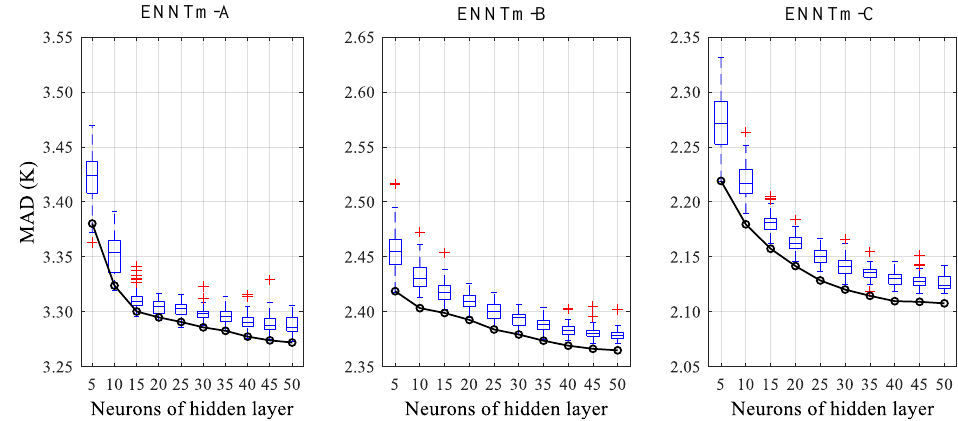
Figure 4. The MAD of different modeling schemes with different BPNN structures.